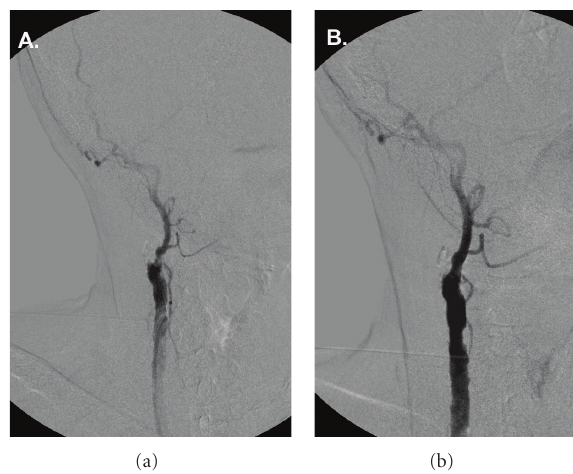
Figure 1: (a) Digital subtraction angiography showing the occluded right internal carotid artery and the significant stenosis of the right external carotid artery. (b) Completion angiogram after angioplasty and stenting of the right external carotid artery showing the resolution of the stenosis, as well as the significant enhancement on ECA’s collateral